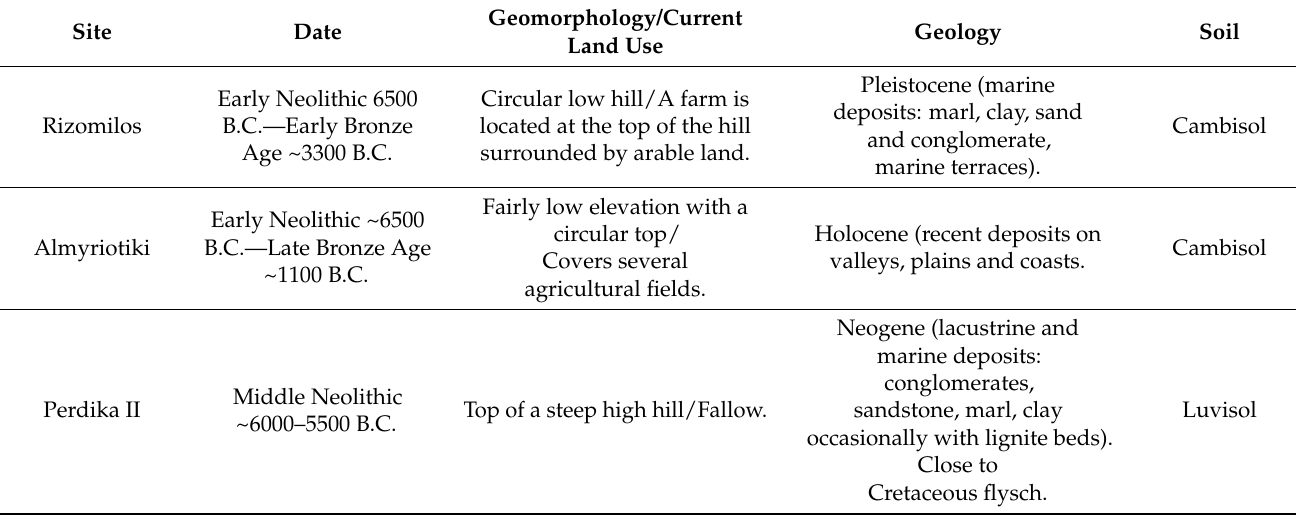
Table 1. General characteristics of the three study